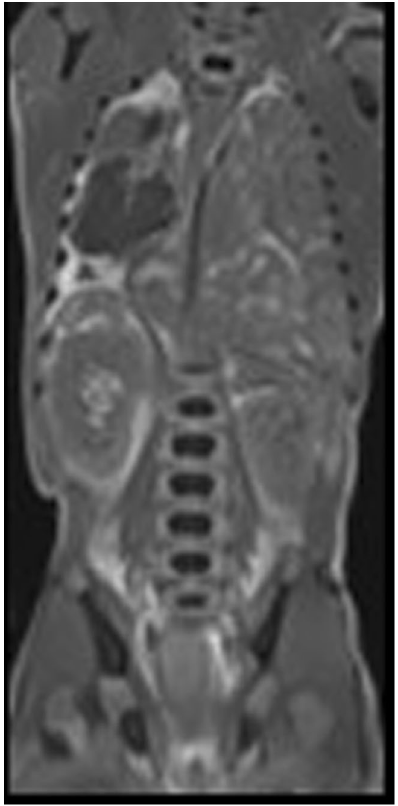
Fig. 11 Coronal T2-W image of a 25 weeks gestation fetus with a left congenial diaphragmatic